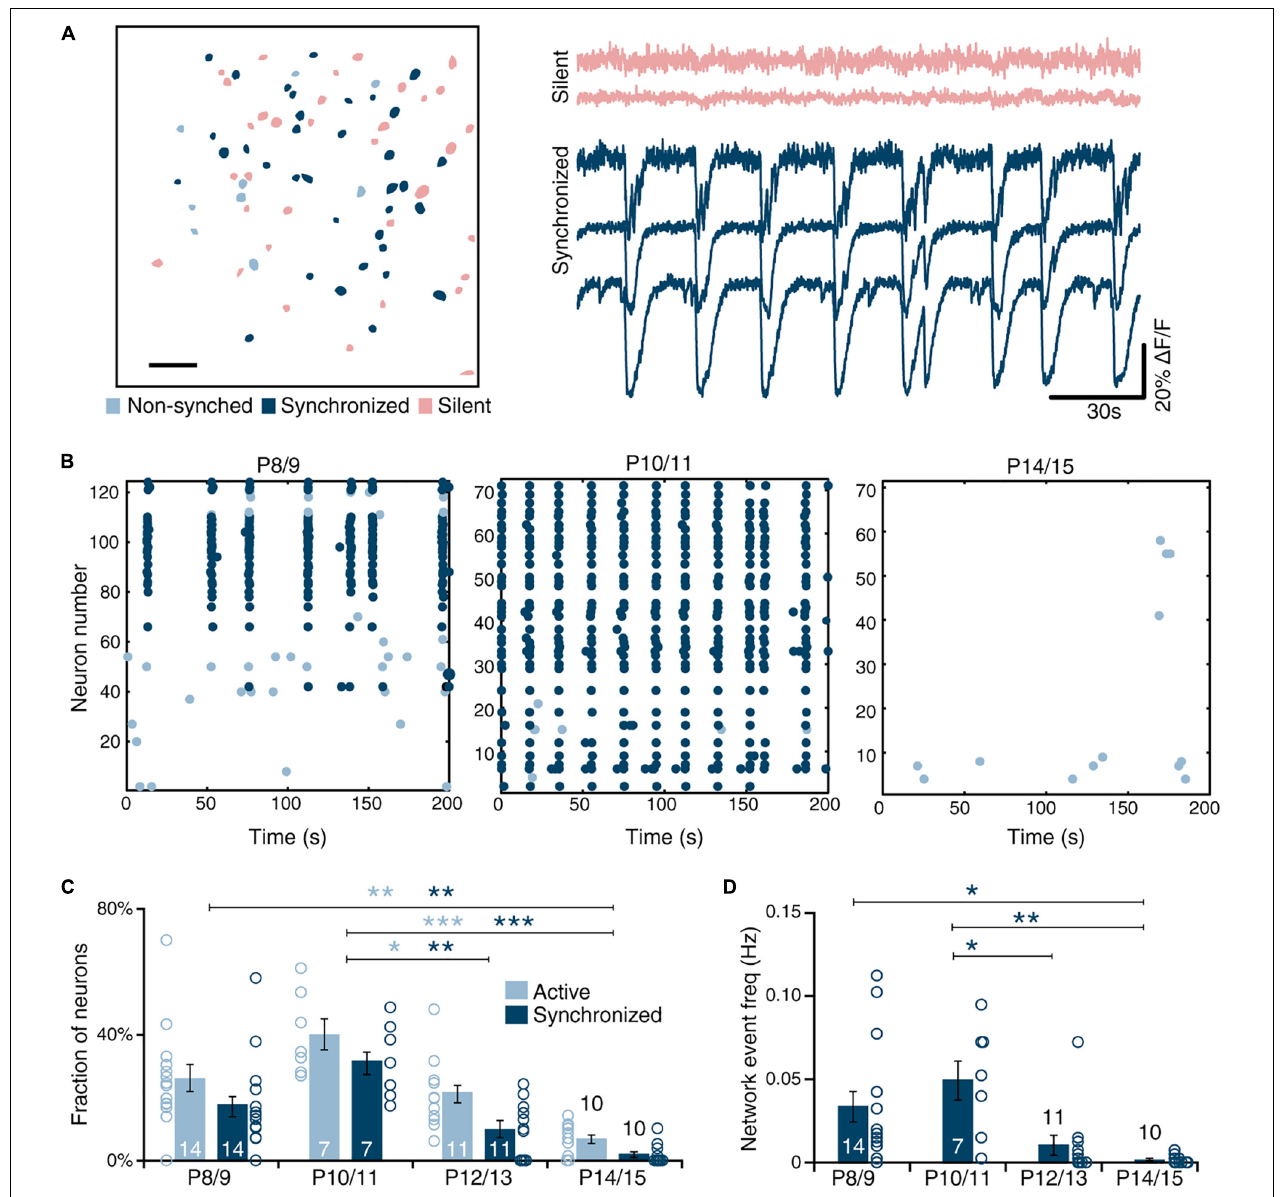
FIGURE 1 | Developmental dynamics of spontaneous sMEC activity. (A) Left: Contour map of Fura2-AM ester bulk-loaded cells in superficial medial entorhinal cortex networks imaged at P10/11. Active neurons (light blue), silent neurons (red), and synchronized neurons (dark blue) indicated. Scale bar 50 µ m. Right: Example traces of silent and synchronously active neurons. (B) Representative raster plots of superficial MEC (sMEC) network activity at P8/9, P10/11, and P14/15, color-coded as in (A) . (C) Quantification of the fraction of active and synchronized neurons during postnatal development showed a significant age-dependent peak at P10/11 in fraction of cells that are active [one-way ANOVA, F (3,41) = 10.1, p < 0.001; Bonferroni corrected, P8/9 vs. P14/15, p = 0.004; P10/11 vs. P12/13, p = 0.028; P10/11 vs. P14/15, p < 0.001], as well as the fraction of cells that are synchronized [one-way ANOVA, F (3,41) = 11.1, p < 0.001; Bonferroni corrected, P8/9 vs. P14/15, p = 0.008; P10/11 vs. P12/13 p = 0.001; P10/11 vs. P14/15, p < 0.001]. (D) Frequency of network events (see section “Materials and Methods” for definition) is highest at P10/11 and virtually absent by P14/15 [one-way ANOVA, F (3,41) = 5.8, p = 0.002; Bonferroni corrected: P8/9 vs. P14/15, p = 0.043; P10/11 vs. P12/13, p = 0.032; P10/11 vs. P14/15, p = 0.006]. Bar graphs represent the mean ± standard error of the mean (SEM). N shown in bars as the number of slices. Number of animals used, P8/9: 4, P10/11: 2, P12/13: 3. P14/15: 2. * p < 0.05; ** p < 0.01; *** p <